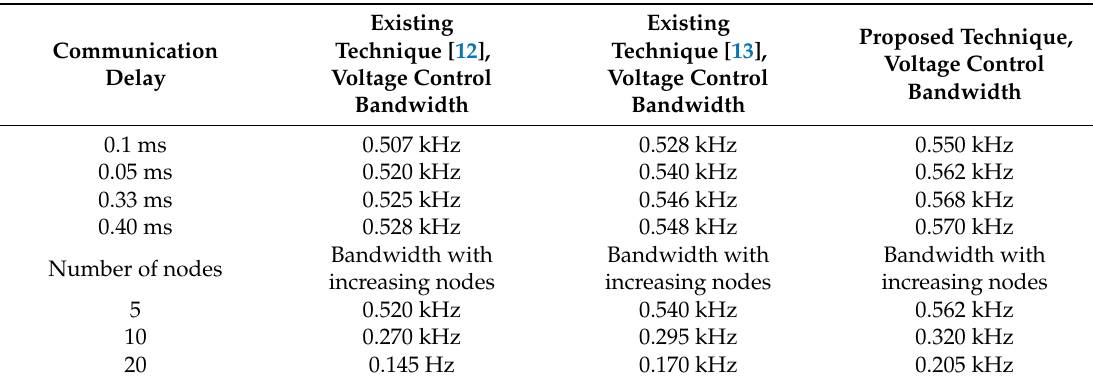
Table 2. Voltage control bandwidth comparison for a four-node system using communication delay and with increasing number of